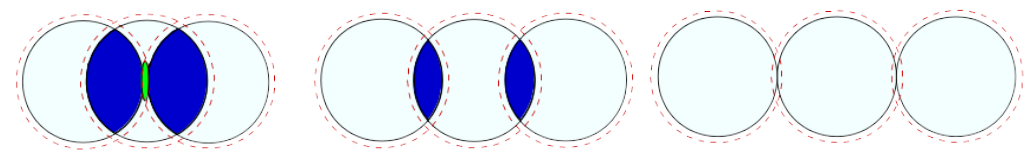
Figure 1. Stiff chains ( left ), semi-flexible chains ( middle ) and flexible chains ( right ) differ by the amount of overlap between adjacent spheres. The dashed red line indicates the range of the square-well attraction, the blue ellipses the inaccessible surface and the green ellipse the overlap of square wells of next-nearest neighbors along the